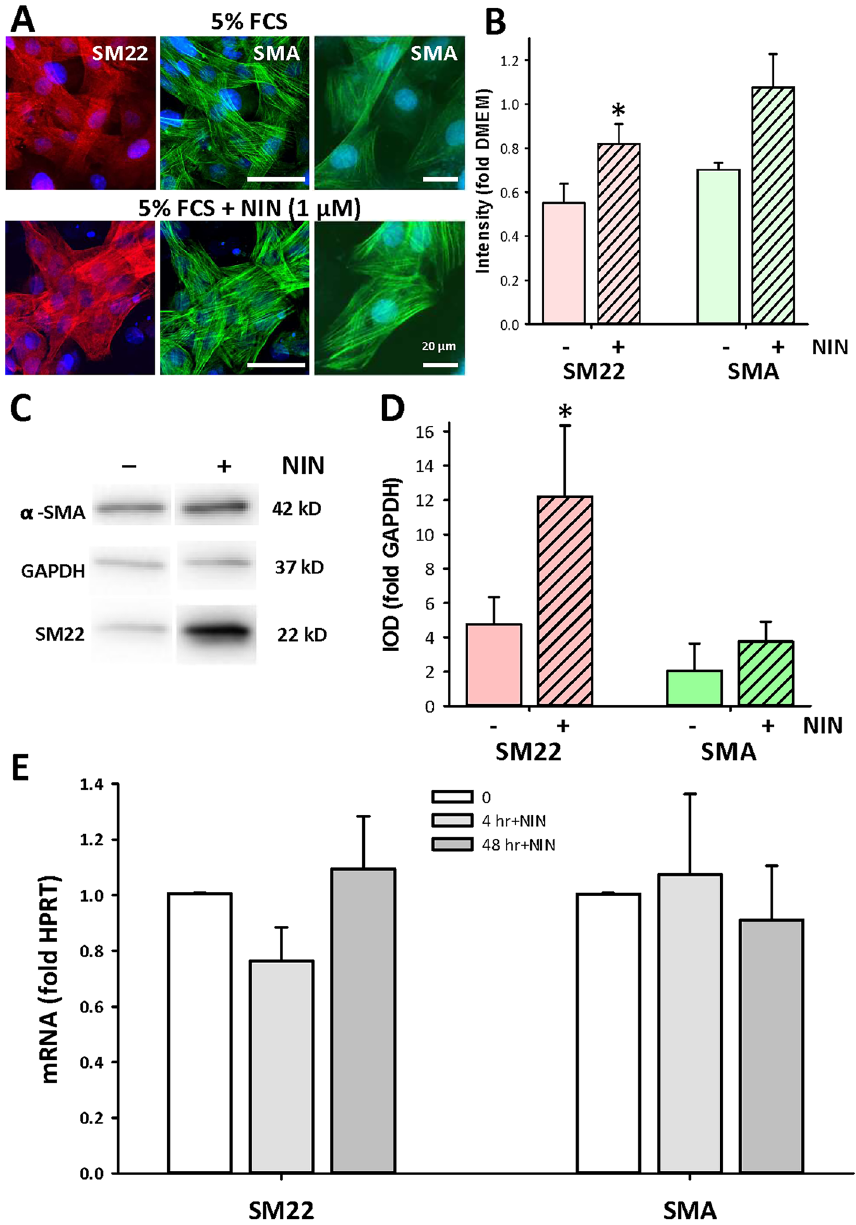
Figure 4. Nintedanib increases expression of smooth muscle marker proteins in high-passage CSMC. ( A ) Immunofluorescent images of high passage CSMC showing labeling for smooth muscle marker proteins SM22 (red) or SMA (green) with nuclei stained with Hoechst (blue). Control (upper) or NIN-treated CSMC (1 µM, 48 h; lower) were imaged identically. Right, higher magnification of SMA staining for each condition. Scale bars, 30 µm (left images) and 20 µm (right images). ( B ) Image analysis of staining intensity for SM22 and SMA in CSMC treated with NIN (1 µM, 48 h). Average line density normalized to black background (n = 4 cell lines, 10–30 cells per cell line, *p < 0.05). ( C , D ) Western blotting for SMA and SM22 protein expression in CSMC treated with NIN (1 µM). ( C ) Representative images selected from independent western blots (see Supplementary Fig. 1 for further detail) and ( D ) outcome of image analysis. Equal cell numbers were loaded per lane (n = 5 cell lines, *p < 0.05). IOD, integrated optical density; GAPDH, loading control. *p < 0.05. ( E ) Quantitative PCR analysis of mRNA expression for SM22 and SMA in control vs NIN-treated CSMC (1 µM). All experiments done in triplicates and normalized to